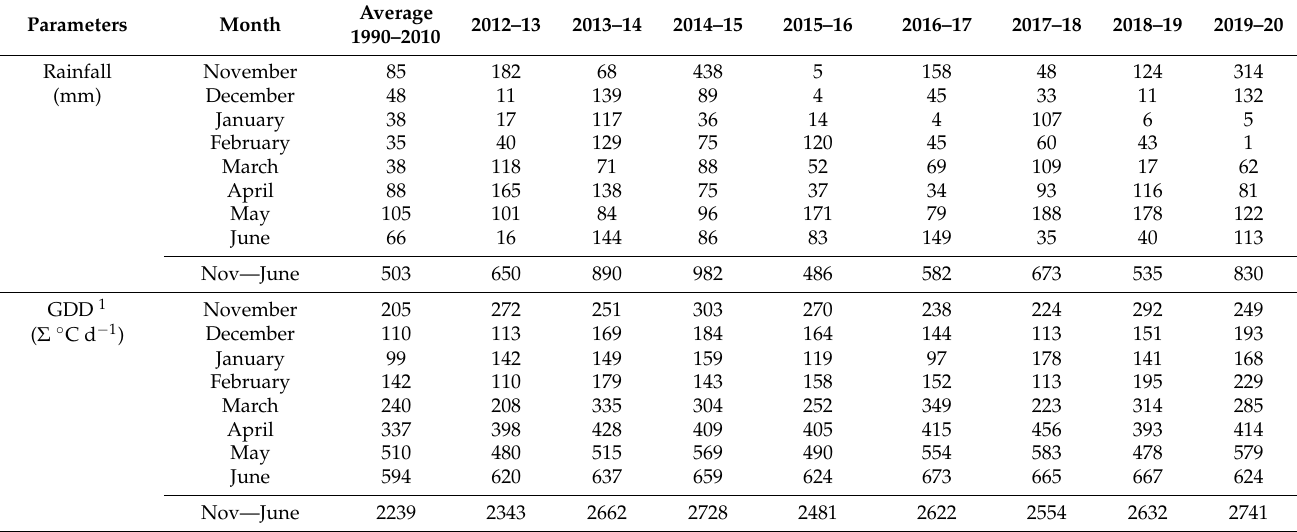
Table 2. Monthly rainfall and growing degree days (GDD) for each growing season compared to data from 1990–2010.